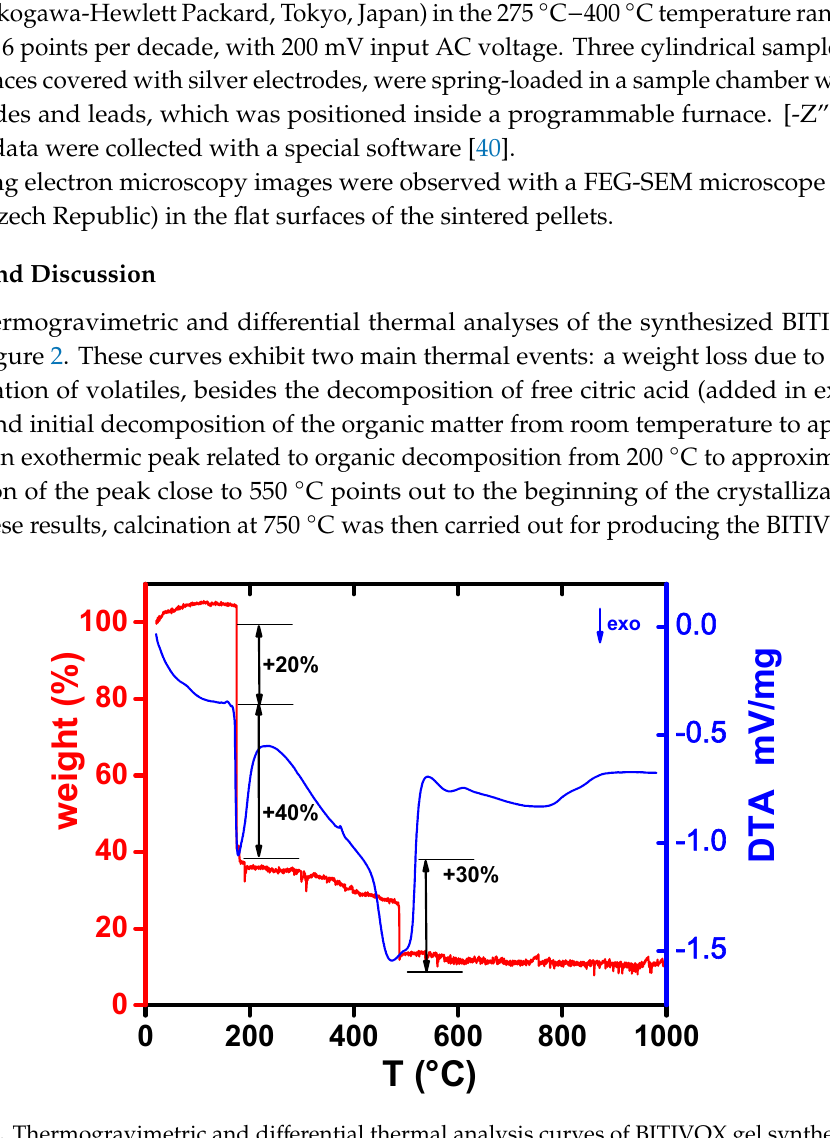
Figure 2. Thermogravimetric and differential thermal analysis curves of BITIVOX gel synthesized by the complex polymerization technique.